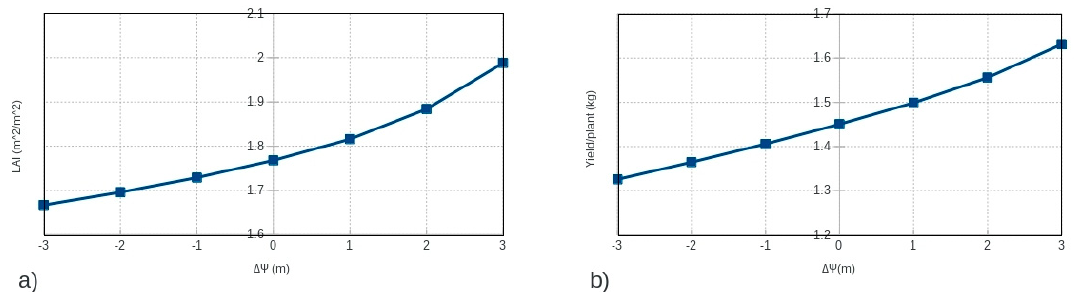
Figure 6. Sensitivity to changes in soil water potential on the maximum LAI (expressed in m 2 m − 2 ) ( a ) and on the yield/vine (expressed in kg) ( b ). ∆Ψ is the difference between the input soil water potential and the actual soil water potential record. Note that 1 m of water potential (hydraulic head) corresponds to about 0.01 MPa of suction.